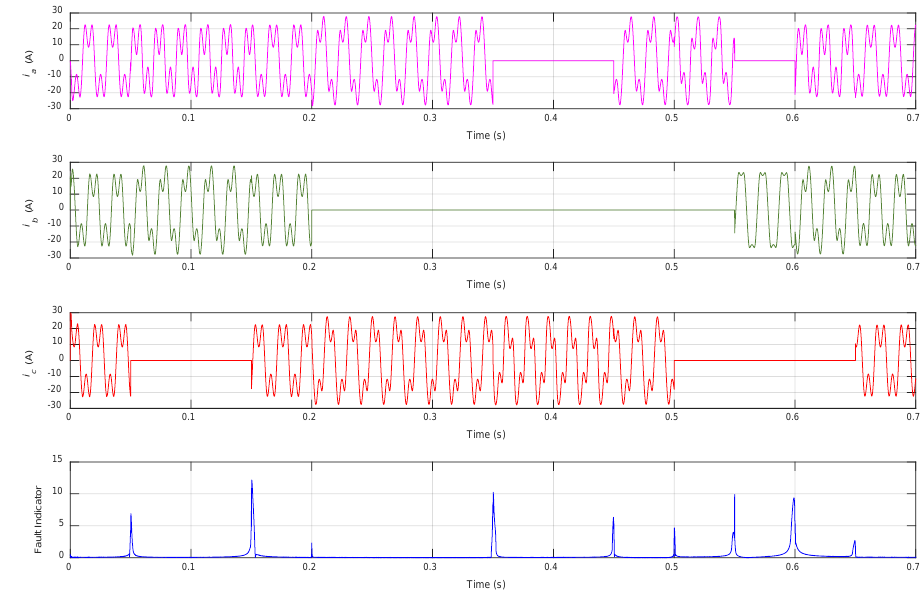
Figure 9. Output currents of three faulty phases with fault indicator.